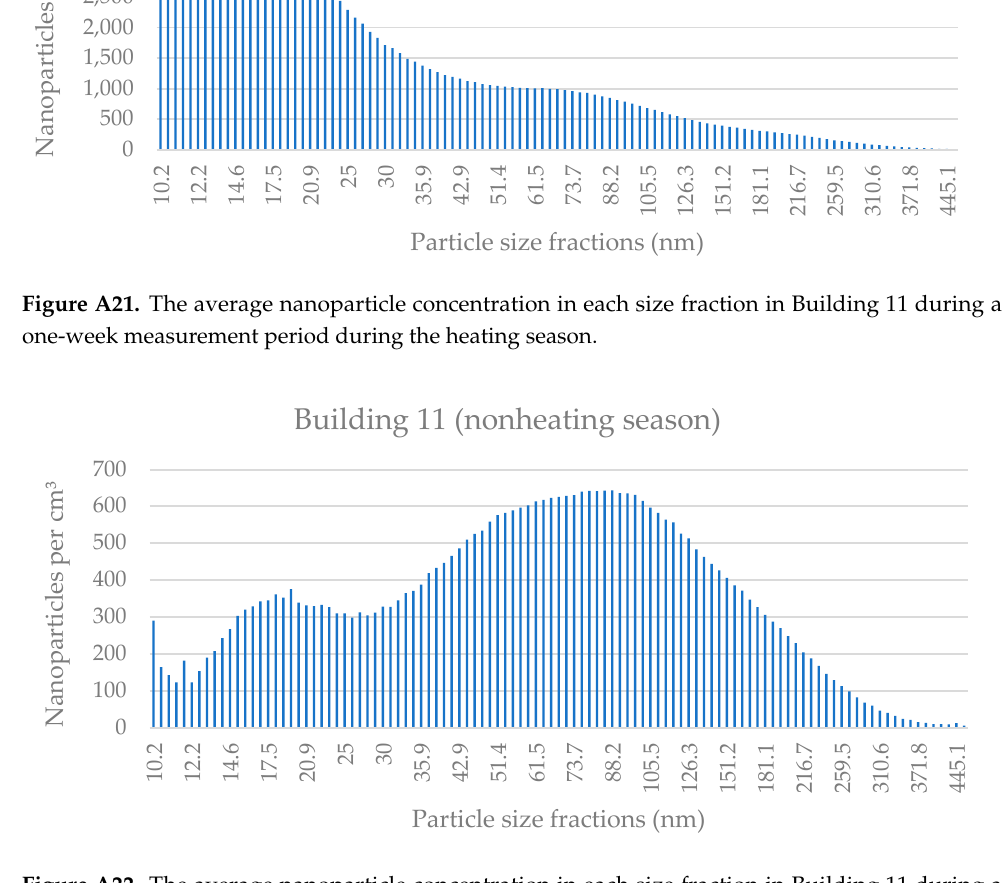
Figure A23. The average nanoparticle concentration in each size fraction in Building 12 during a one-week measurement period during the heating season. Figure A24. The average nanoparticle concentration in each size fraction in Building 12 during a one-week measurement period during the nonheating season.